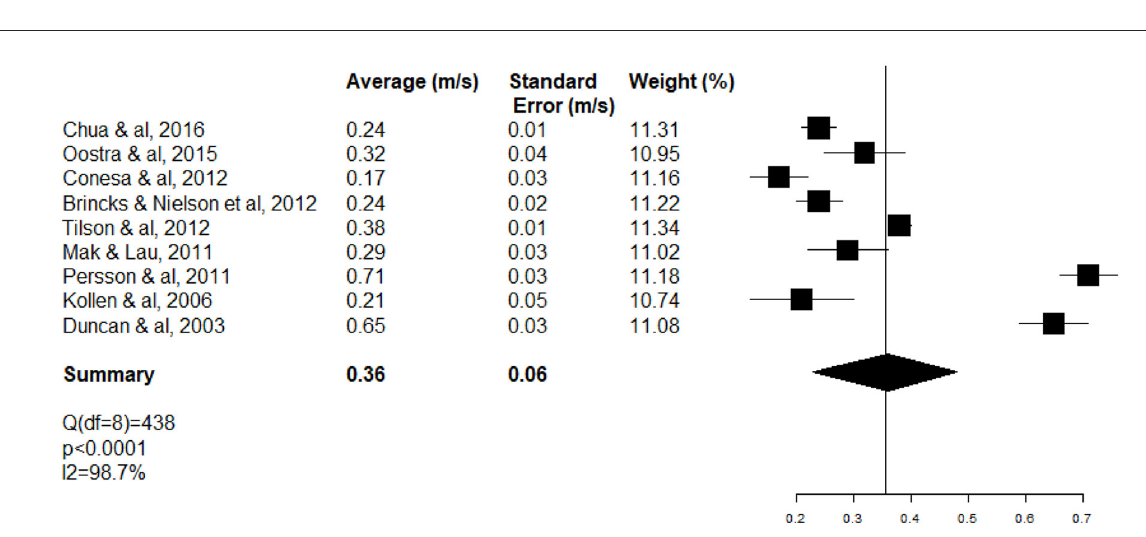
FIGURE3 Forest plot of short-distance WS at the acute and subacute stages of stroke